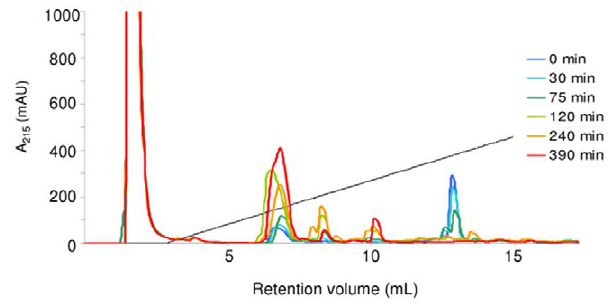
Figure 1. An example set of HPLC chromatograms from various time points of Lfc9 incubated in 25% human male serum at 37 u C, showing the degradation of the intact peptide ( , 13 mL ret. vol.) and appearance of its partially digested products (5–